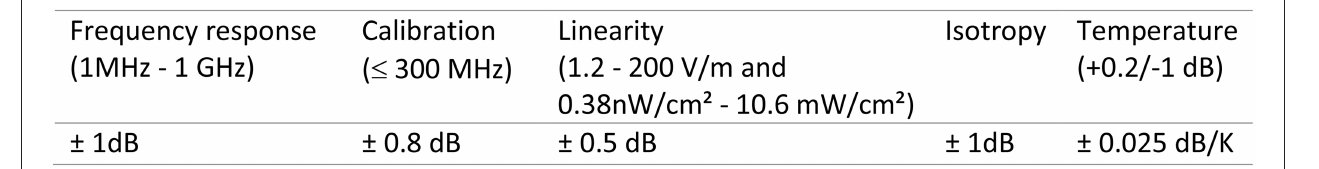
FIGURE 6 | Example of uncertainties as given by narda sts for one of their electric field probes, 100 kHz